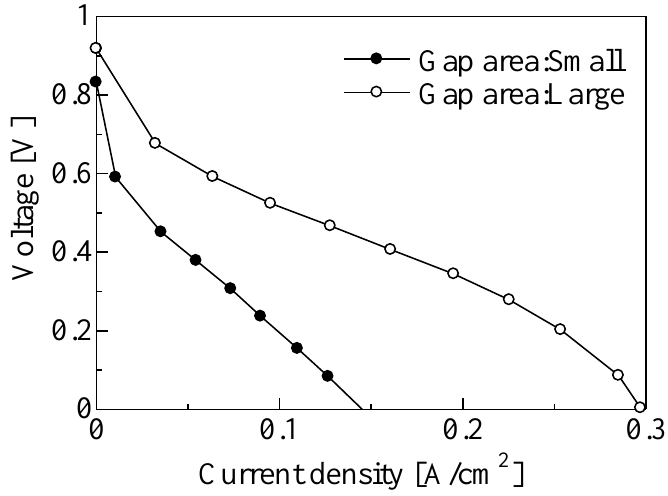
Figure 10. Voltage – current density (V – J) curve of single PEFC cells of Pt/CNWs/MPL/CP for different gap areas.